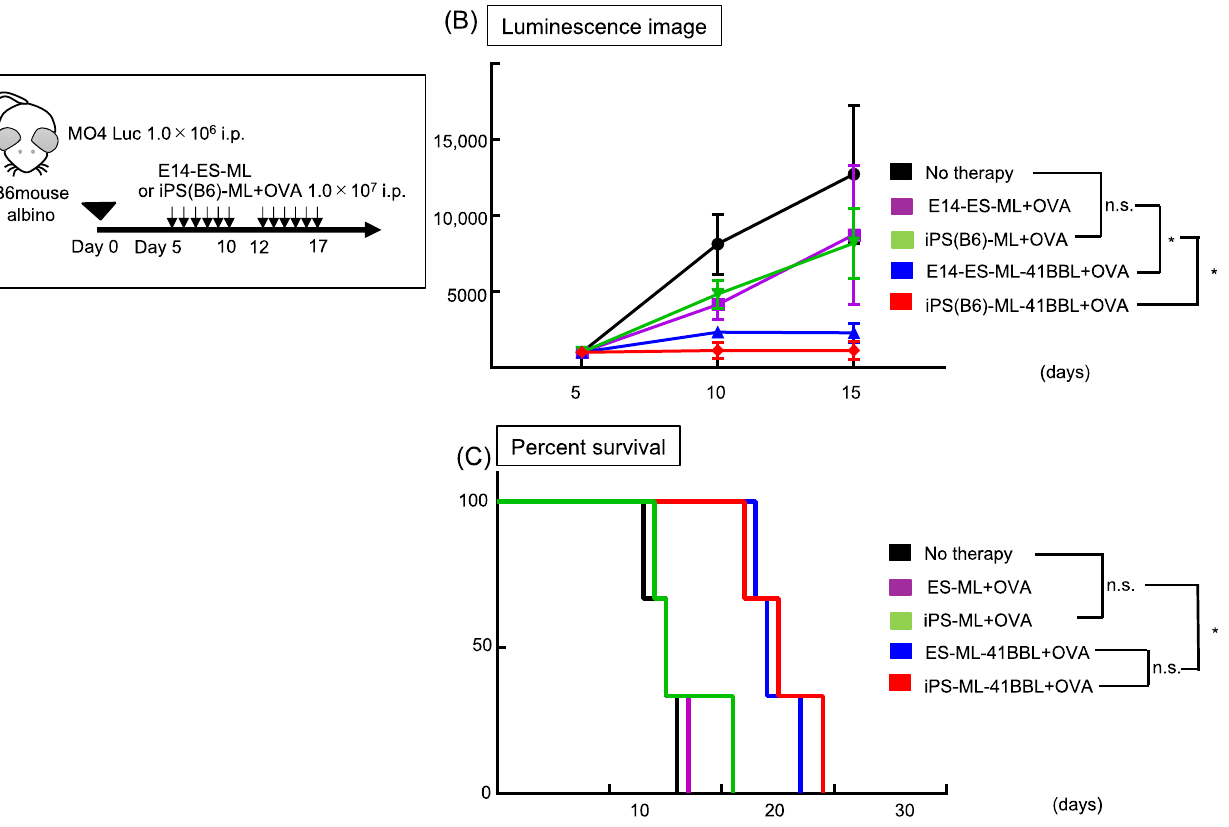
Figure 5. Effects of ES-ML-41BBL against MO4 melanoma in vivo. ( A ) The model of treatment schedule. ( B ) Luminescence images showing tumor growth. ( C ) Plots showing fold change in tumor-associated luminescence at day 5. Kaplan-Meier plot of overall survival and median survival time (MST). n.s. = not significant * p < 0.05.